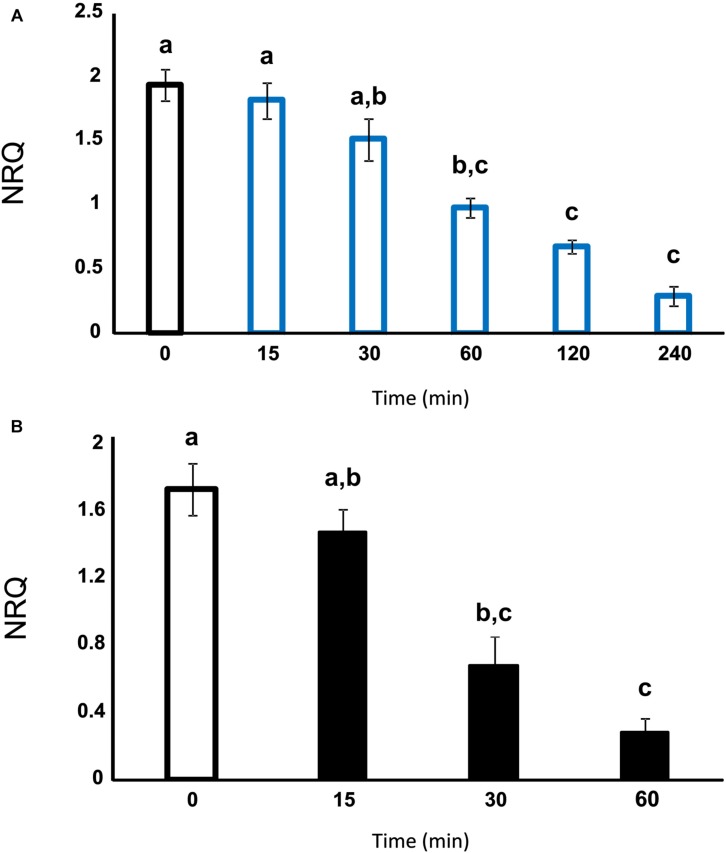
blsA expression levels rapidly respond to illumination or temperature changes. (A) Estimation by RT-qPCR of the blsA expression levels in ATCC 17978 cells grown until DO = 0.5 in LB at 24°C in the dark (D) (t = 0), and then switched to light conditions. (B) Estimation by RT-qPCR of the blsA expression levels in ATCC 17978 cells grown until DO = 0.5 in LB in the dark (D) at 24°C (t = 0), and then switched to 37°C. Samples were taken at the indicated times. The data shown are mean ± SD of normalized relative quantities (NRQ) obtained from transcript levels of blsA from cells incubated at the indicated temperatures under blue light or in the dark, measured in three biological replicates. Different letters indicate significant differences as determined by ANOVA followed by Tukey’s multiple comparison tests (p < 0.05).